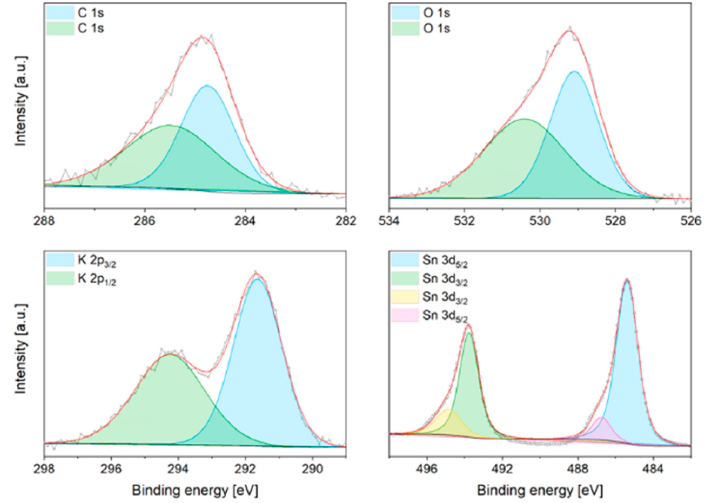
Figure 8. XPS of KB before carbonation. The surface morphology of K-B before and after carbonation was studied by SEM. Figure 9a K-B showed clear agglomeration of particles, heterogeneity in size distribution, and microporosity. The close-up in Figure 9b shows two types of surfaces: (i) a smooth layer, and (ii) a more irregular surface layer (possibly K-rich) on top of the other layer. Previous work showed similar morphology explaining this superficial layer of K species covering SnO 2 particles related to the strong philicity of K-O bond of K-species towards the Lewis acidic sites (Sn 4+ -O) present on the surface of SnO 2 [34]. Figure 9c,d instead shows the morphology of K-B after three carbonation/calcination cycles at different reso- lutions. The sorbent surface seems made of homogeneous molten phase with presence of macro/mesopores more abundant than the starting one, suggesting some mineral phase rearrangement (as supported by the XRD analysis) by K/Sn/O species migration and tem- perature-related cracking. Free-moving K + and OH − ions and oxygen radicals produced by high reaction temperature quickly diffuse into tin oxide structure to form molten phase of K 2 SnO 3 /K 4 SnO 4 , which nucleate out in different crystals structures [24]. This is con- firmed by the zoomed Figure 9d, also suggesting the presence of different potassium stan- nate phases, since nanowires, micro sub-spherical, elongated hexagonal prisms, and larger irregular shaped particles are visible. Similar shapes were assigned to K 2 SnO 3 and K 2 Sn 3 O 7 by EDX in previous work [34]. K 2 SnO 3 is a layered structure itself in which the growth predominantly happens at its ends (at edge sites) that can result in nanowires [24]. It can be extrapolated from the SEM pictures that the K-B sorbent was synthesised in the form of fine particles (average size <50 micron). Even though such fine particles can be easily used and tested for characterization in static analysis systems, such as those used in this work, their applicability in actual dynamic systems even at lab-scale, such as fluid- ized bed reactors, is very challenging. In this context, the use of small sorbent particles can strongly limit sintering and pore-plugging, thus consequently enhancing the multicyclic ability [35]. Moreover, sound-assisted fluidization was proposed as a viable technique to allow the use of such fine particles in fluidized bed reactors, thus overcoming the strict limitation posed by particle size applicable in ordinary fluidized bed reactors [36].